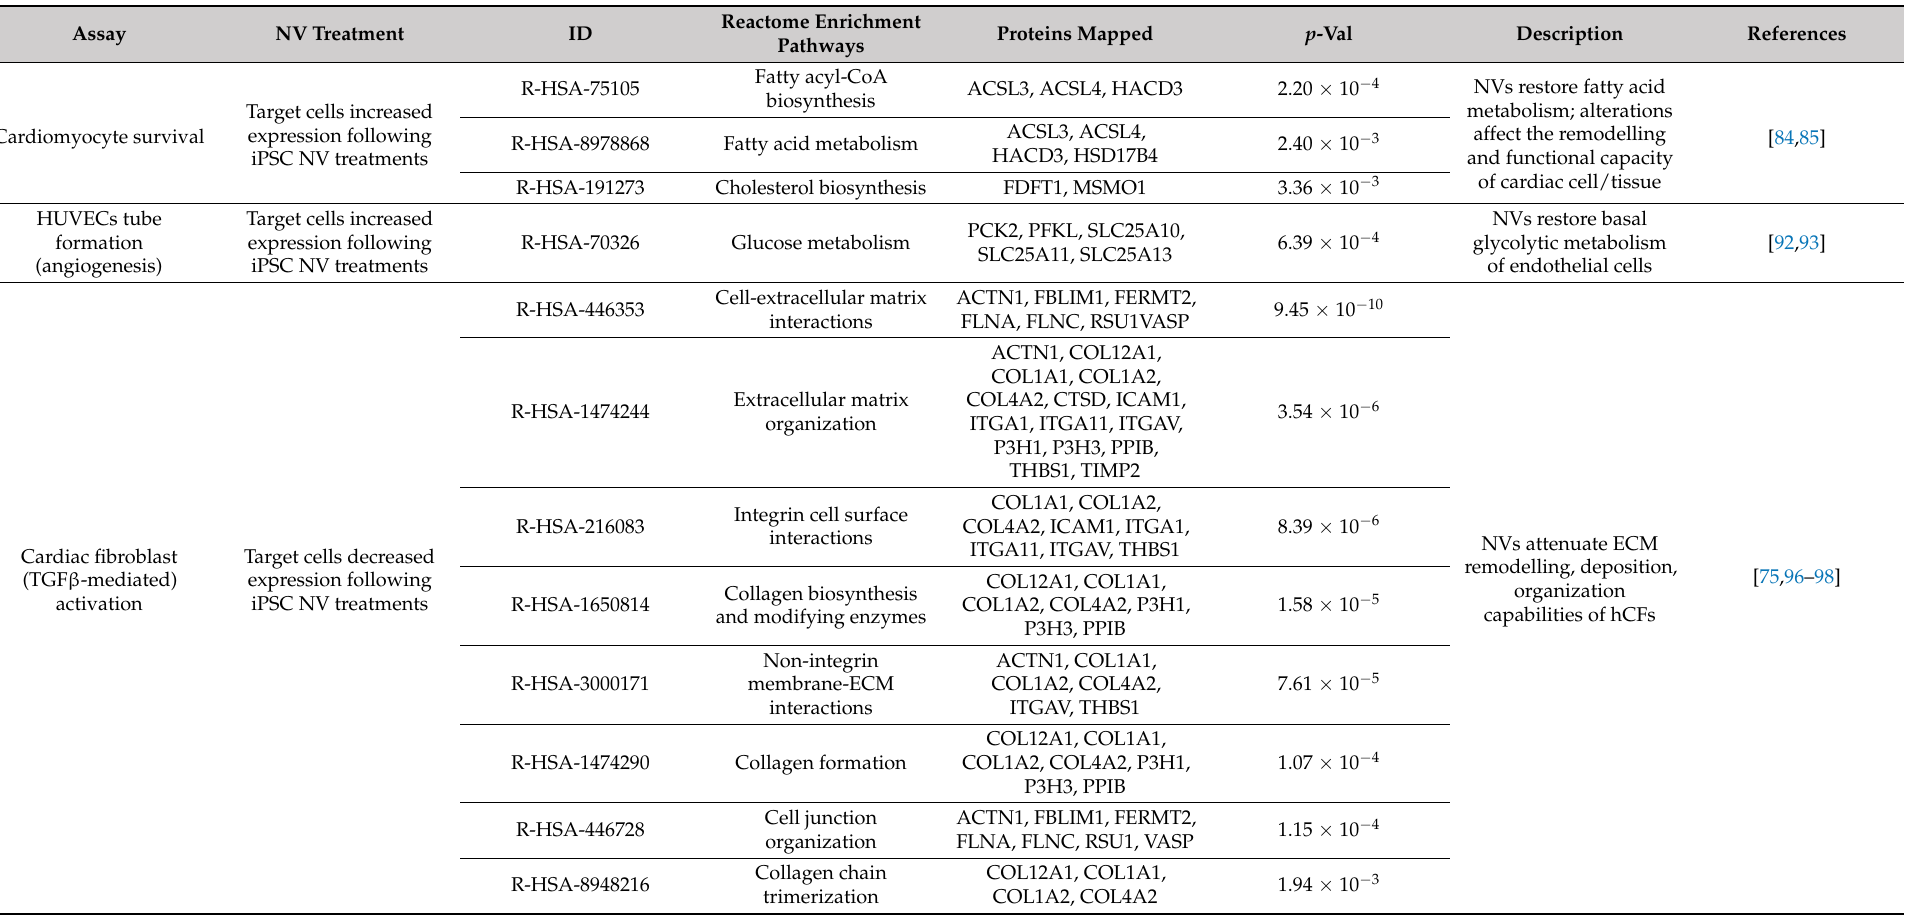
Table 1. iPSC NVs induce proteome reprogramming of target cells to support repair